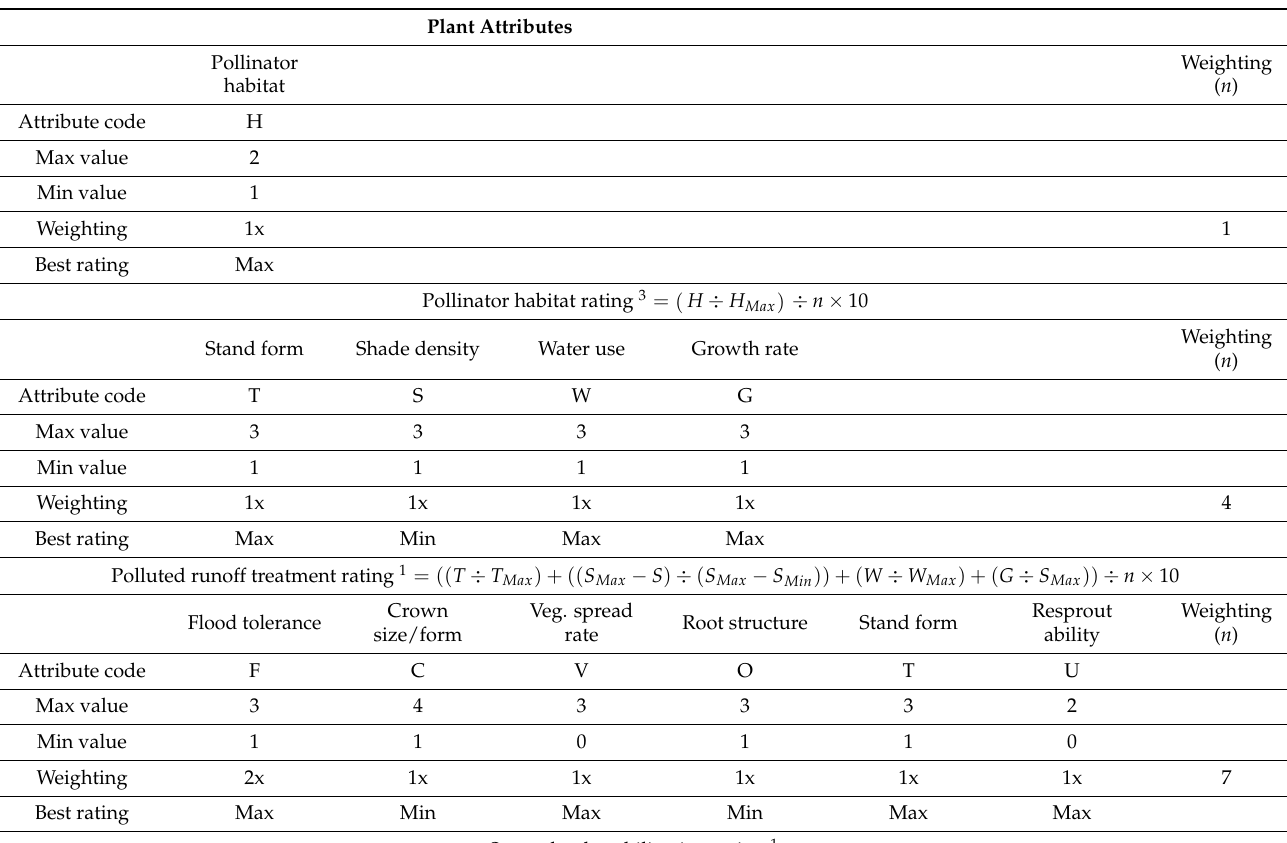
Table 3. Cont. Plant